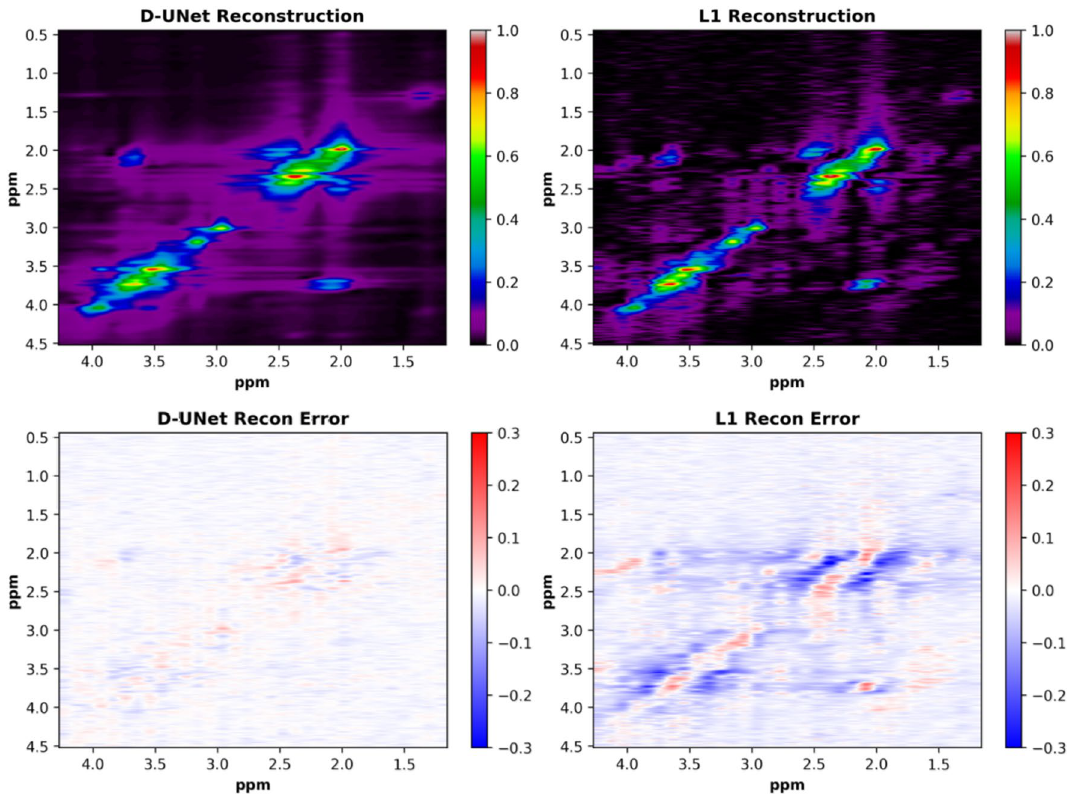
Figure 4. A qualitative comparison between the D-UNet and the compressed sensing ( ℓ 1 -norm) reconstructions is shown. The fully sampled L-COSY spectrum displayed in Fig. 2 was sampled using 25 t 1 points (4x acceleration). The spectrum was then reconstructed using the trained deep learning model and optimization described in Eq. (3). Errors between the two reconstructions are displayed as differences between the actual spectrum and the